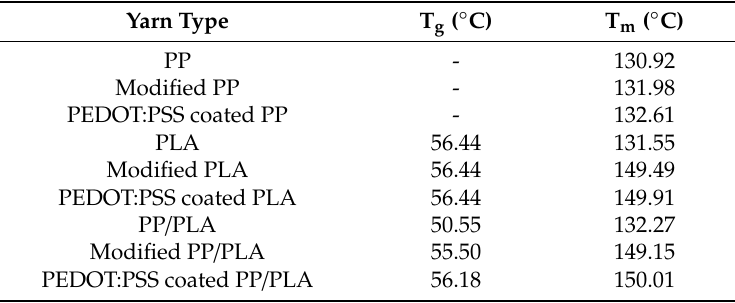
Figure 13. Differential scanning calorimetry (DSC) thermograms of PDA treated and PEDOT:PSS coated ( a ) PP, ( b ) PLA and ( c ) blend PP / PLA yarn. Table 5. DSC results of glass transition temperature (T g ) and melting point (T m ) of PDA treated and PEDOT:PSS coated PP, PLA and PP/PLA yarns.